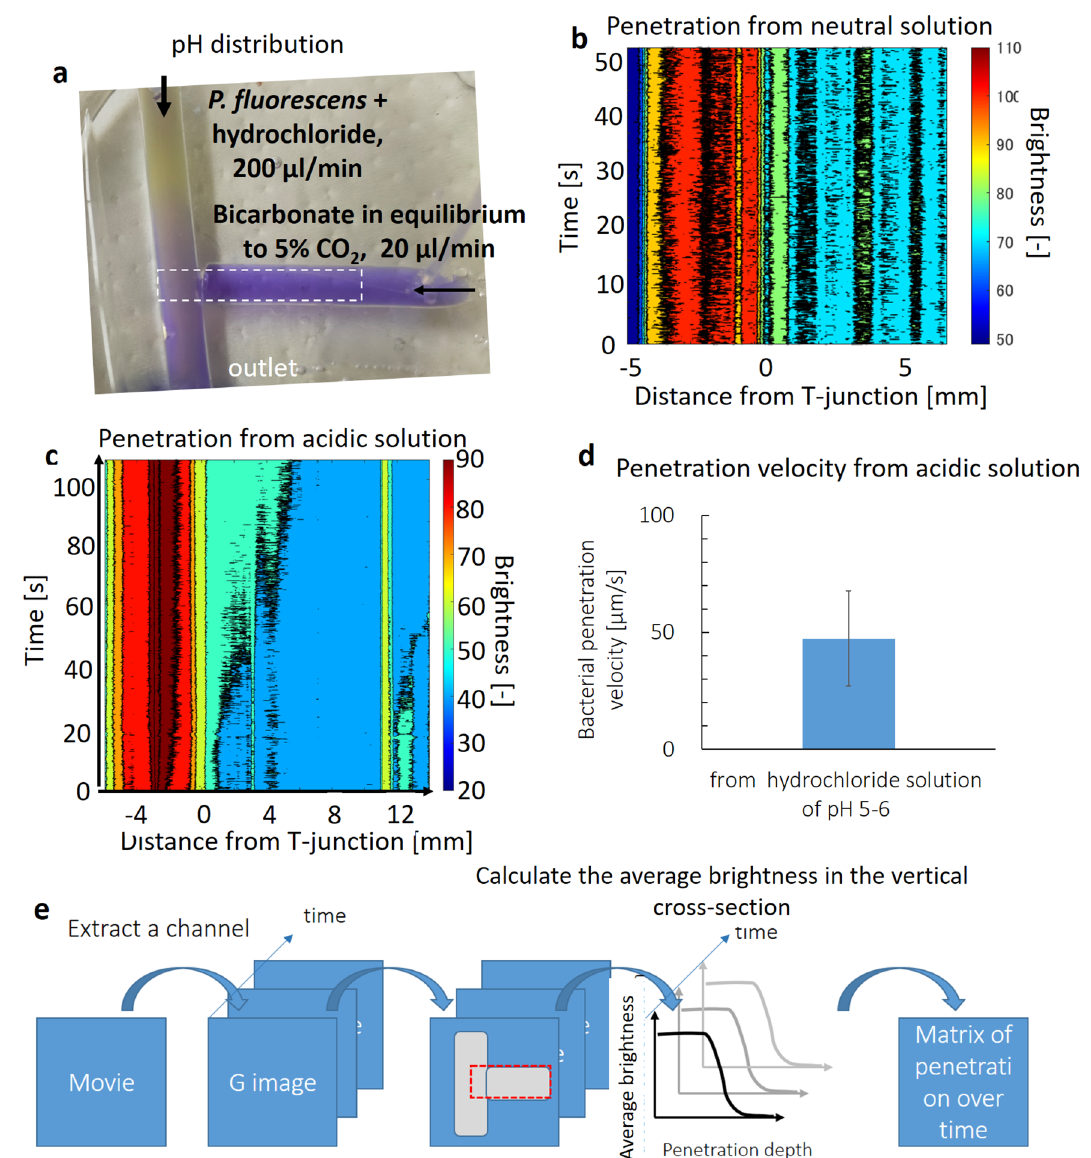
Figure 7. Migration of P. fluorescens from hydrochloride solution against the bicarbonate flow of μl/min was measured in a simply fabricated PDMS four-millimeter diameter T-shaped cylinder. a : Distribution of pH in the T-shaped cylinder is visualized in bromocresol purple. The pH increased from 5–6 in dark yellow at the top to purple (neutral) at the right and the bottom of the cylinder. b : An example of bacterial distribution over time from bicarbonate solution as a control. c: P. fluorescens migrated upstream against flow under the pH gradient at the T-junction ( a ) with a penetration rate of approximately 50 μm/s. d : Average bacterial penetration velocity in three different experiments. e: A procedure for calculating a matrix of bacterial penetration depth over time ( b , c ). Bacterial distribution was quantified from the brightness of the image of each frame in the movies, under UV light in dark condition, which corresponds to the intrinsic fluorescence of P. fluorescens